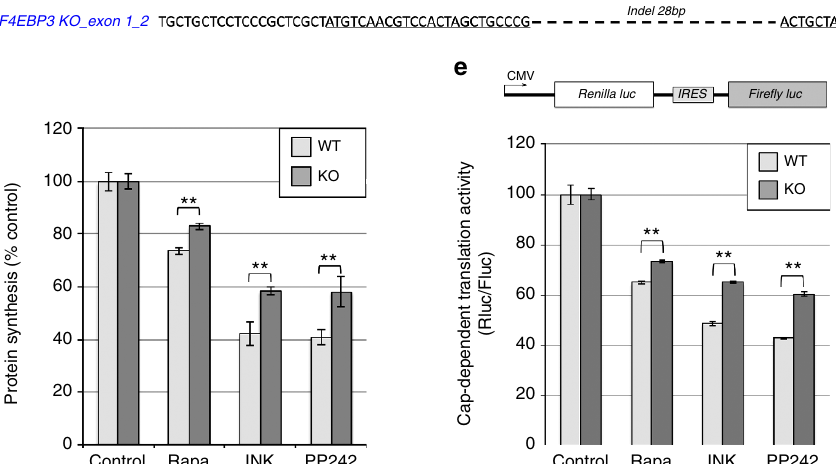
BEZ235. Consistent with the results obtained with cultured cells (Fig. 1), 4e-bp3 mRNA expression, but not 4e-bp1 and 2 , was significantly induced in tumours administered with each drug (RAD001 (2.5-fold) or BEZ235 (3.0-fold) alone) (Fig. 6a,b). The combination of RAD001 and BEZ235 on 4e-bp3 expression had